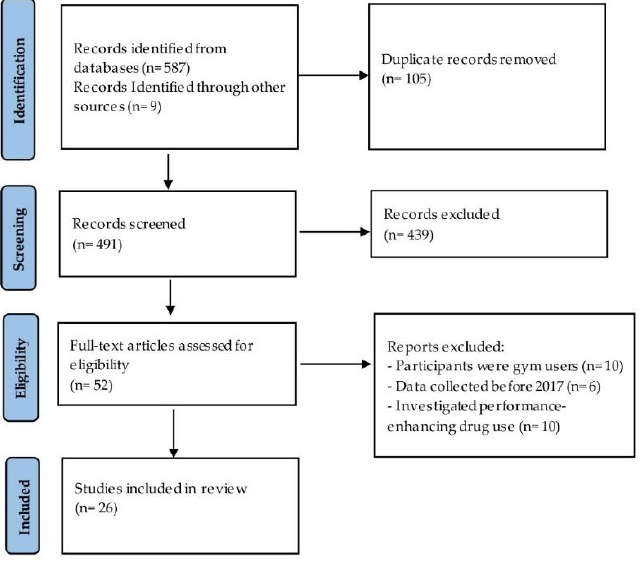
Figure 1. Selection of sources of evidence.